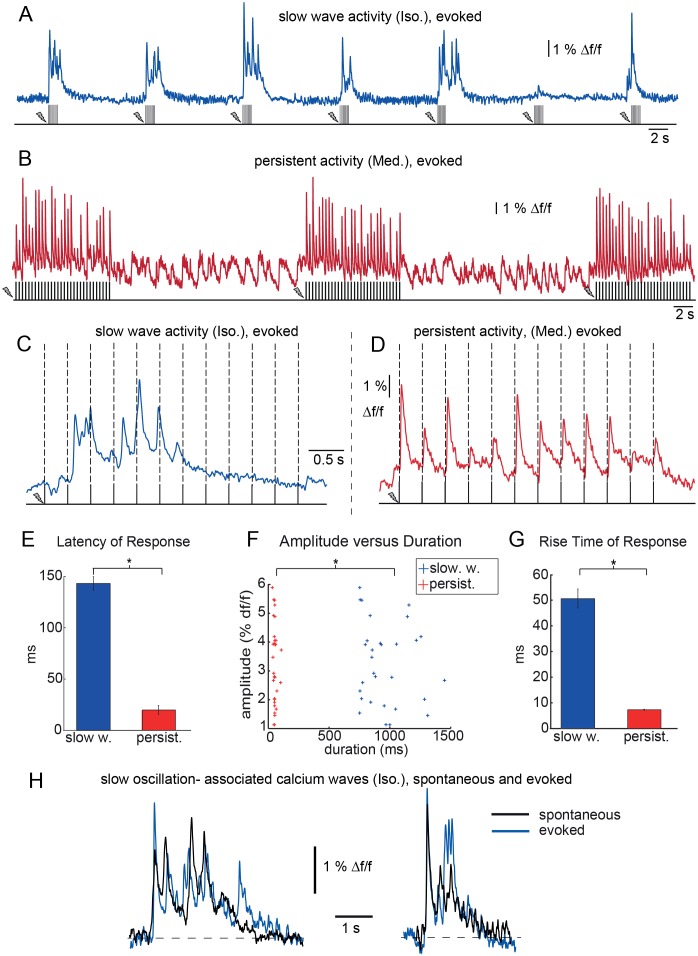
Neuronal response patterns upon sensory stimulation for slow wave and persistent activity.(A) Calcium trace recorded during slow wave activity (blue). Electric forepaw stimulation at 9 Hz for 1 s every 10 s. Calcium waves were evoked in an all-or-none manner. The last pulse train started during the occurrence of a spontaneous wave. (B) Calcium trace recorded during persistent activity (red). Electric forepaw stimulation at 3 Hz for 10 s every 30 s resulted in short-latency calcium transients upon each pulse. (C) Individual sensory evoked slow calcium wave, note that wave is locked to the onset of the first stimulus with a latency of 140 ms (stimulation paradigm: 3 Hz, 4 s). (D) Sensory-evoked calcium responses during persistent activity (stimulation paradigm: 3 Hz, 4 s). Each pulse evoked an individual response. (E) Latencies of evoked calcium waves during slow wave activity (blue) vs. responses during persistent activity (red). Latencies differ significantly by more than 100 ms. (F) Scatter plot displaying mean response amplitudes versus durations measured at 50% of maximum peak in the two conditions. Duration of responses (slow wave vs. persistent response) differs significantly by more than 900 ms. (G) Mean rise times of responses in the the two conditions differ significantly. Asterisks indicate significant difference (rank sum test, p<0.0001, 30 events, three animals). (H) Slow oscillation-associated calcium waves evoked by sensory stimulation are indistinguishable from spontaneously occurring waves. For slow wave activity, we observed electric forepaw stimulation to reliably evoke slow waves locked to stimulus onset (A) with a mean latency of 143 ms ± 7 ms (30 events, three animals, (E), in reasonable agreement with studies in mice using visual or auditory stimulation (Grienberger et al., 2012; Stroh et al., 2013). Regarding signal characteristics, stimulus-evoked calcium waves were not distinguishable from spontaneous waves (H), again in agreement with previous studies (Stroh et al., 2013). Stimulating with multiple pulses with a frequency of 3 Hz and pulse train duration of 4 s led to calcium waves with latencies similar to those waves induced by single pulses (C). Subsequent pulses within a given pulse train did not evoke additional waves, suggesting refractory behavior of those waves, as previously shown in mice. Waves followed all-or-none characteristics (A), with a probability of induction of 72%±8% (five animals, 12 traces). In the persistent activity condition, we detected neuronal calcium responses upon sensory stimuli with a significantly shorter latency of 20 ms ± 4 ms and a significantly shorter duration of 55 ms ± 3 ms, in agreement with previous studies (Schmid et al., 2016) versus 959 ms ± 36 ms in slow wave state (30 events, three animals, (E, F). The amplitudes of persistent activity responses slow waves did not differ significantly (F), but varied between individual animals due to different staining efficiencies. It has to be noted that amplitudes of calcium transients can only be meaningfully compared within one experiment, as the fluorescence amplitudes depend on many local parameters, such as the concentration of the calcium indicator in the region and the position of the optic fiber. Responses during persistent activity exhibited significantly shorter rise times compared to slow waves (G), suggesting a different mechanism of activity initiation.